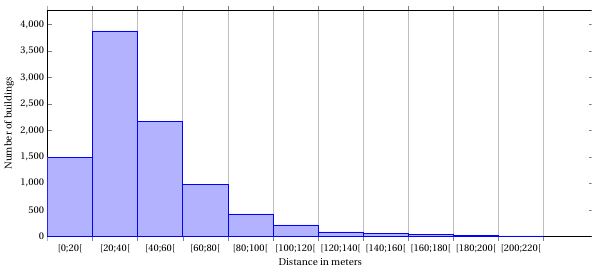
Figure 4. Number of buildings according to their distance from the nearest network